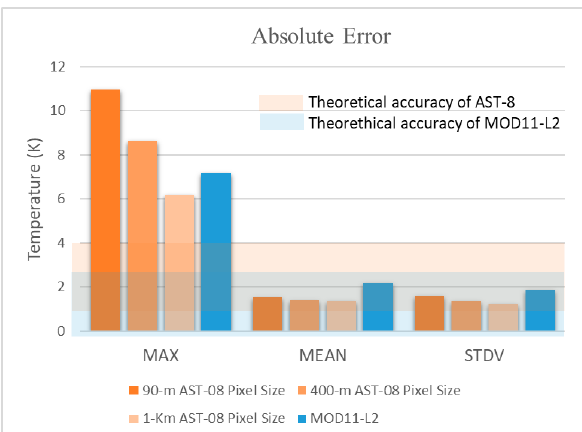
Figure 8. Maximum, mean and standard deviation of the absolute errors obtained when using AST-08 product at the three spatial resolutions analysed (in orange) and when using MOD11-L2 (in blue).